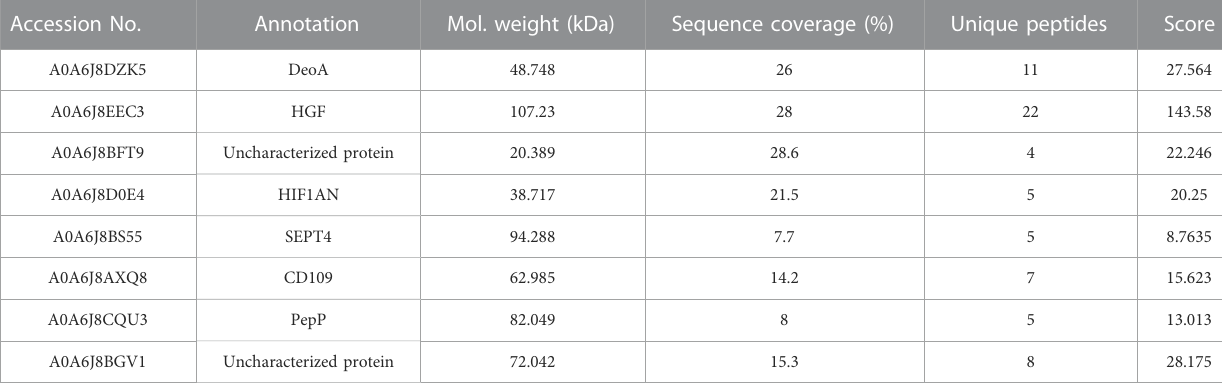
TABLE 3 Signi fi cant downregulated proteins. Accession